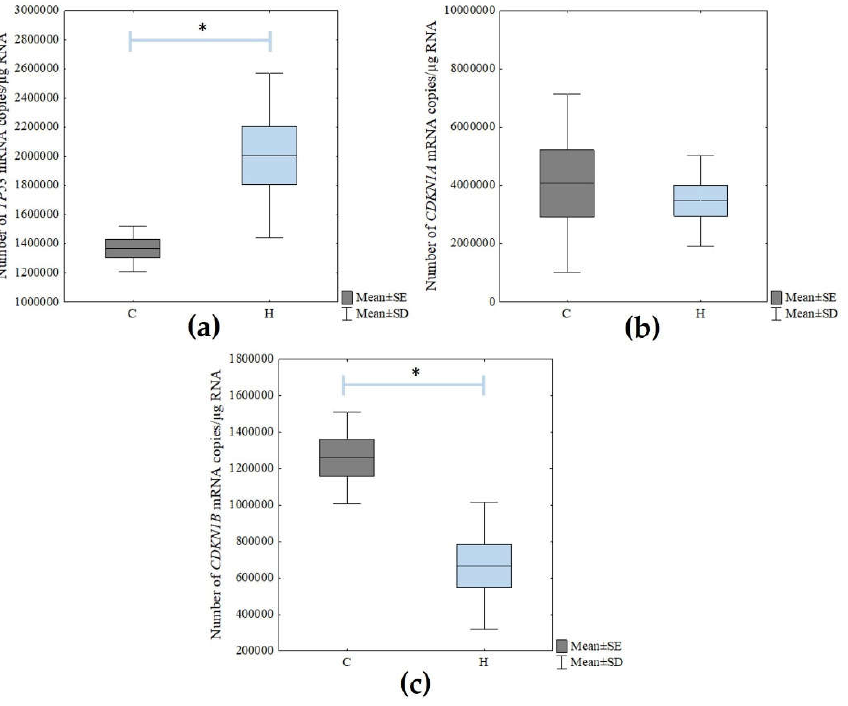
Figure 4. Changes in the mRNA levels of ( a ) TP53, ( b ) CDKN1A and ( c ) CDKN1B genes in non-treated (C) and H 2 O 2 -treated (H) ARPE-19 cells. The box and whisker plots present the mean ± standard error (SE) and standard deviation (SD) of copy numbers per 1 µ g of the total RNA; Student’s t -test; * p < 0.05 versus C. Sample size: three biological and three technical replicates for each test group.